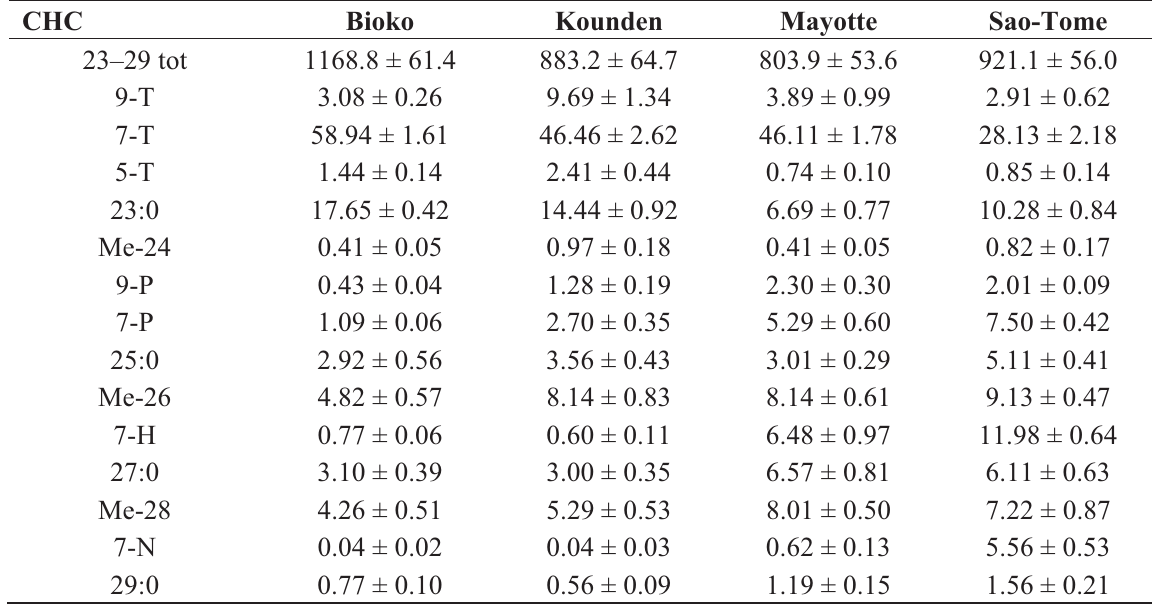
Table 2. Female CHC profiles of four strains of D. yakuba